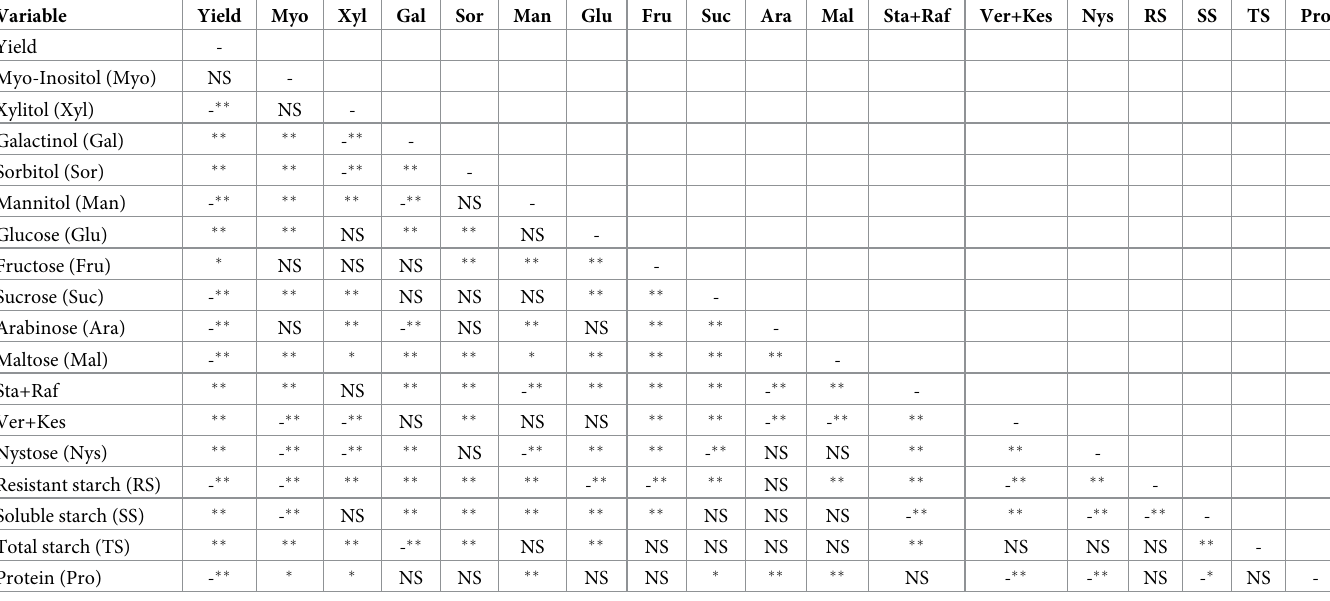
Stachyose and Raffinose (Sta+Raf); Verbascose and Kestose (Ver+Kes) �� significant at P < 0 . 05 �